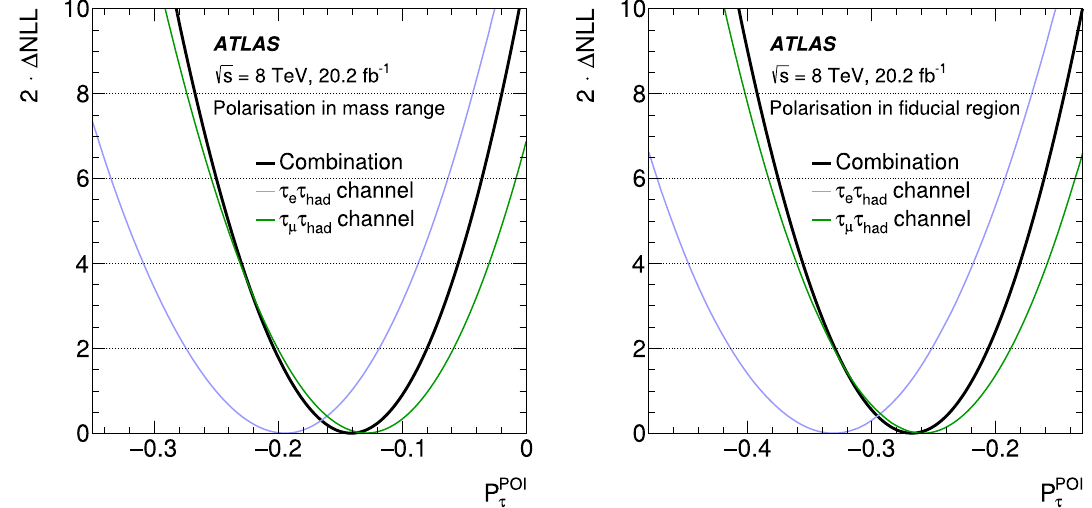
Fig. 6 Likelihood profiles of P POI τ for the fits that extract the polarisation in the mass-selected region of 66 < m Z /γ ∗ < 116 GeV (left) and in the fiducial region (right). The profiles are shown separately for the fits in the τ e – τ had and τ μ – τ had channels and for the combination